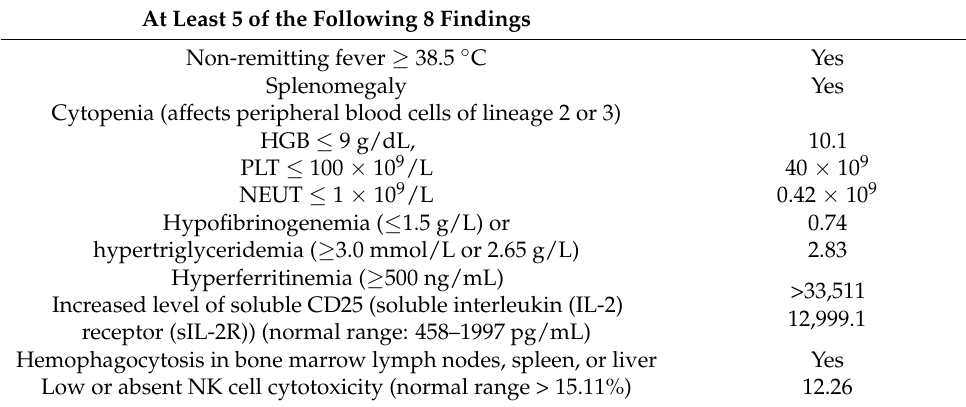
Figure 3. No signs of malignancy were seen in this patient. ( A ) Microscopically, the lymph node structure was destroyed, and no obvious lymphoid follicle structure was found. The interfollicular area and lymphatic sinus were enlarged. Significant histiocyte infiltration with phagocytosis of